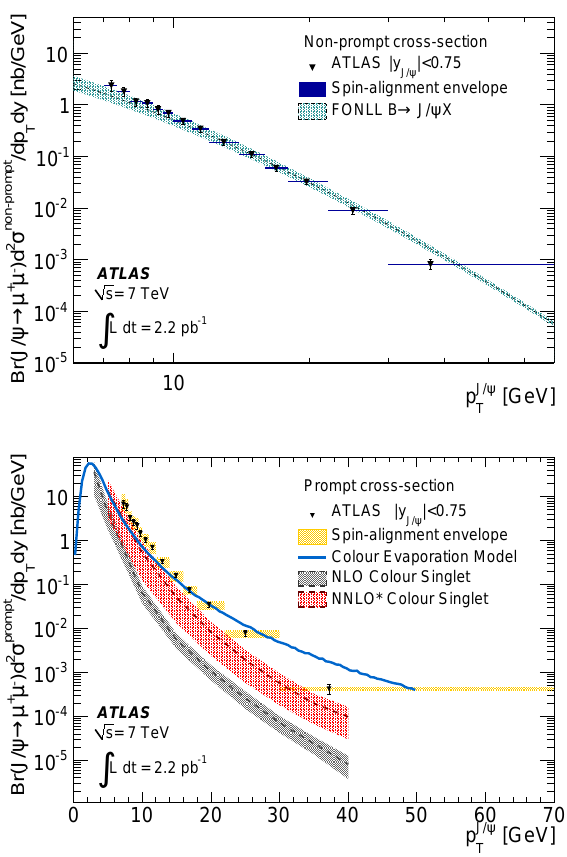
Fig. 4. Non-prompt (top) and prompt (bottom) J /ψ production cross-sections as a function of J /ψ transverse momentum, com- pared to theoretical predictions (FONLL, in the case of non- prompt production; NLO and NNLO* and Colour Evaporation Model predictions for prompt production). Overlaid is a band rep- resenting the variation of the result under various spin-alignment assumptions on the non-prompt and prompt components. The central value assumes an isotropic polarisation for both prompt and non-prompt